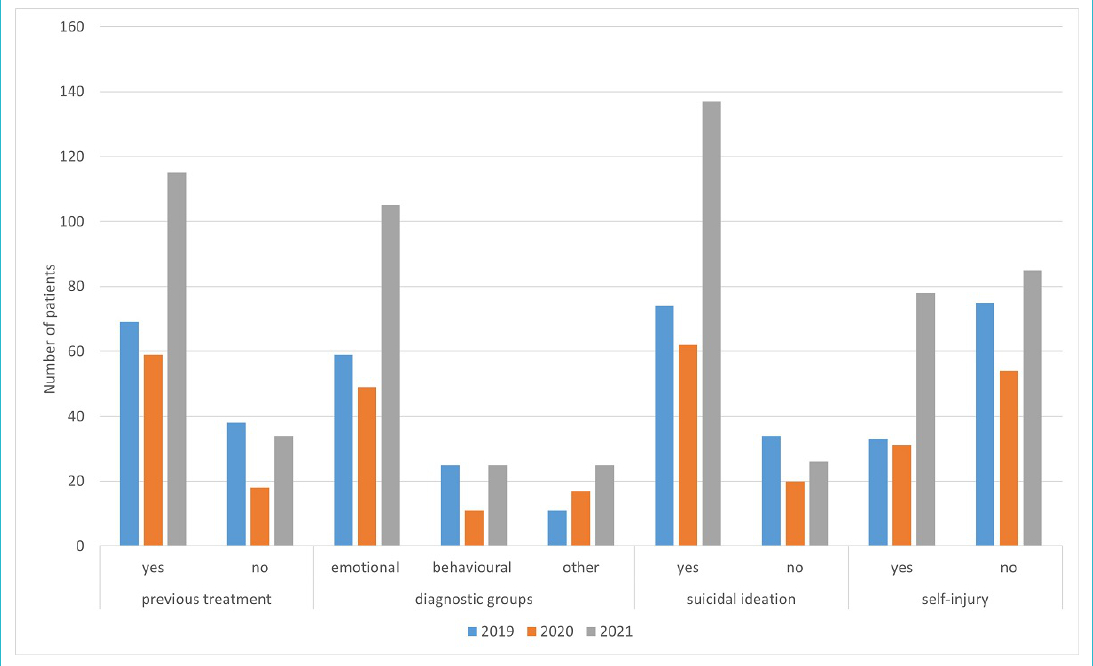
Figure 3: Previous psychiatric treatments, diagnostic group, suicidal ideation and self harm. Emotional disorders (F3, F4, F93), behavioural disorders (F90, F91)